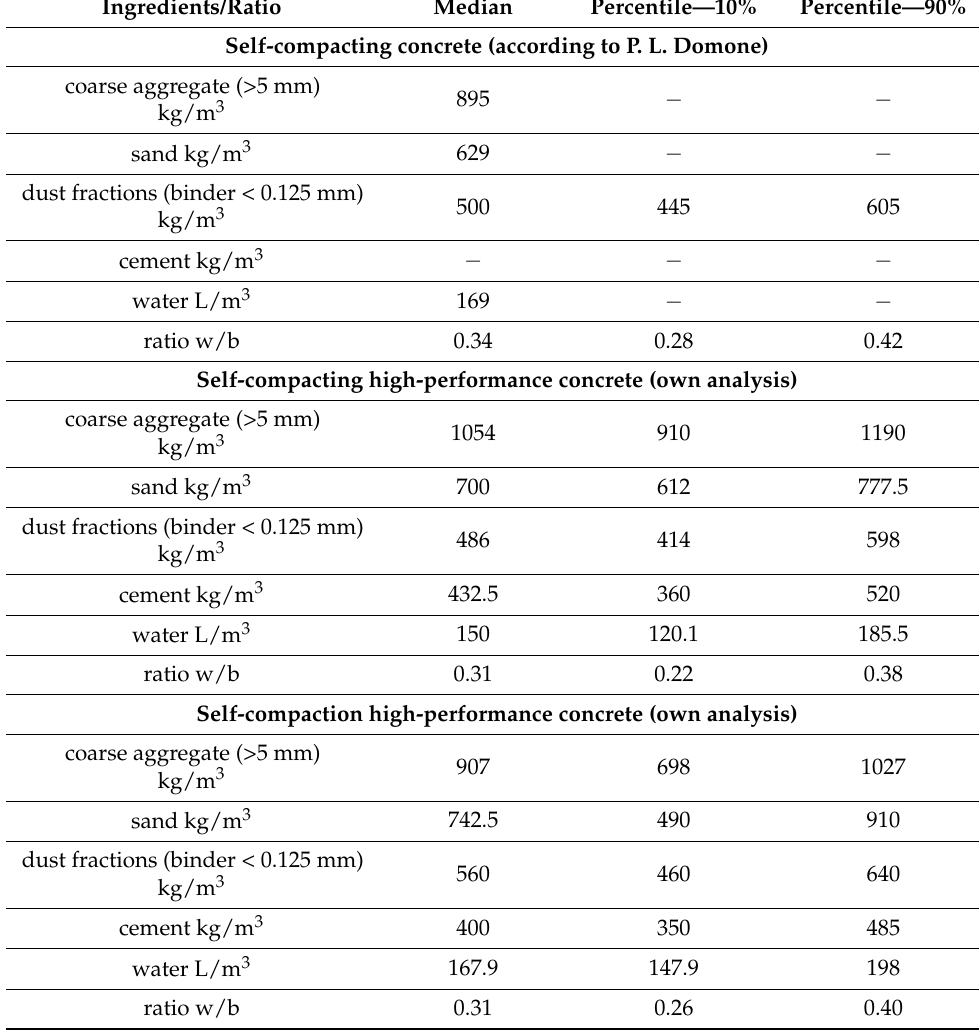
Table 2. Mix design (medians and percentiles) and w/b for concretes: SCC, HPC, and HPSCC. Ingredients/Ratio Median Percentile—10% Percentile—90% Self-compacting concrete (according to P. L.